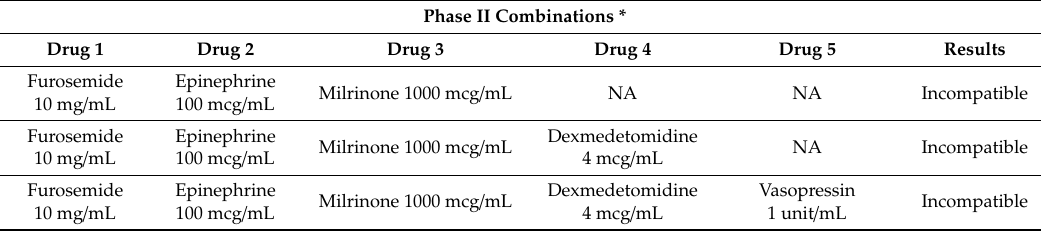
Table 4. Phase II.1-II.3 overall physical compatibility results.